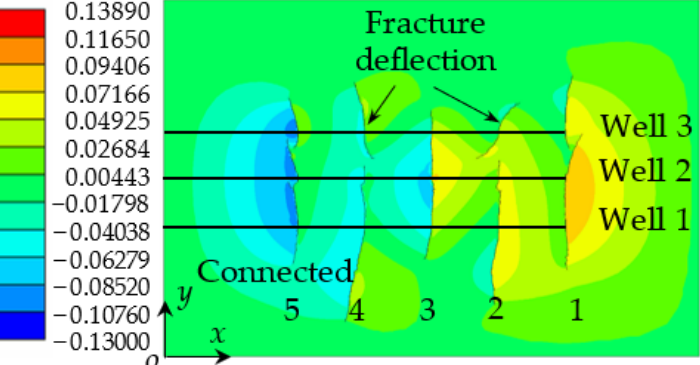
Figure 11. Final fracture network morphology and deformation in multi-well fracturing; b = 50 m.